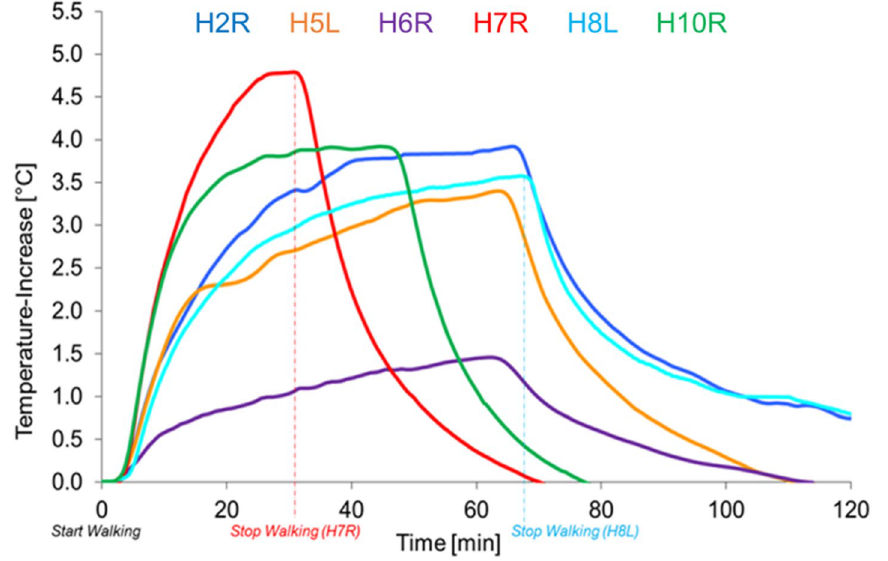
Figure 2. Individual in vivo measured temperature increases during treadmill walking at 4